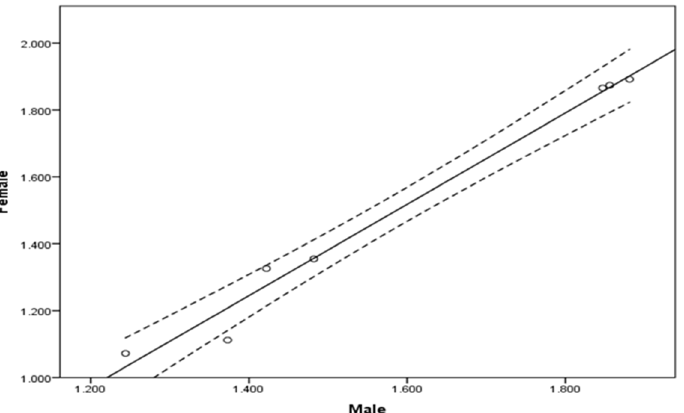
Figure 13. The regression line male and female study group, Turesky Modified Quigley–Hein Plaque Index.